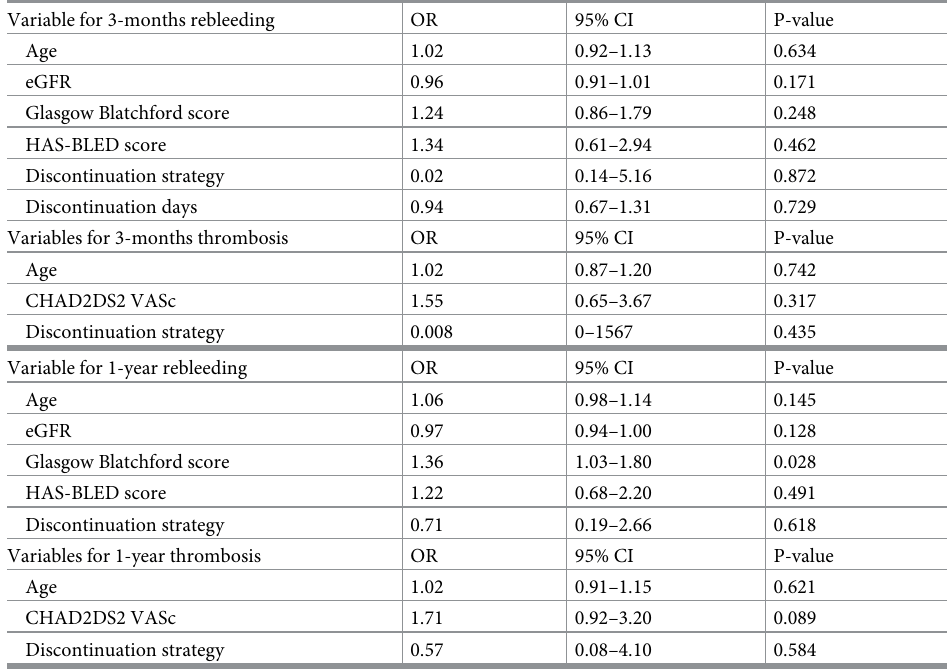
Table 5. Univariate binary logistic regression analyses for predicting 3 months’